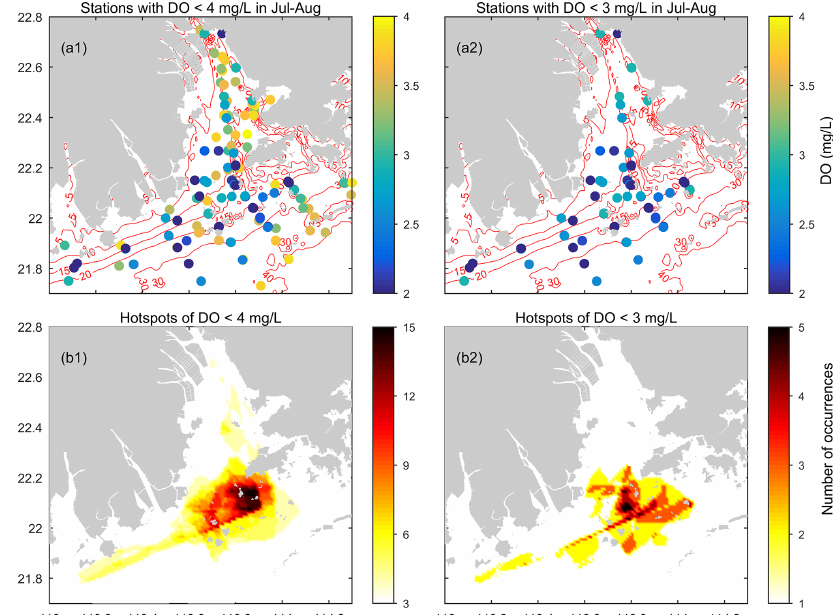
Figure 7. (a) The sites where low-oxygen conditions have been observed in the summer of the PRE and the corresponding lowest DO values measured (based on the data compiled from 1976 to 2017). (b) Maps showing the incidence of low-oxygen conditions at the bottom of the PRE in summer. Note that the darker color delineates a higher occurrence of low-oxygen events.